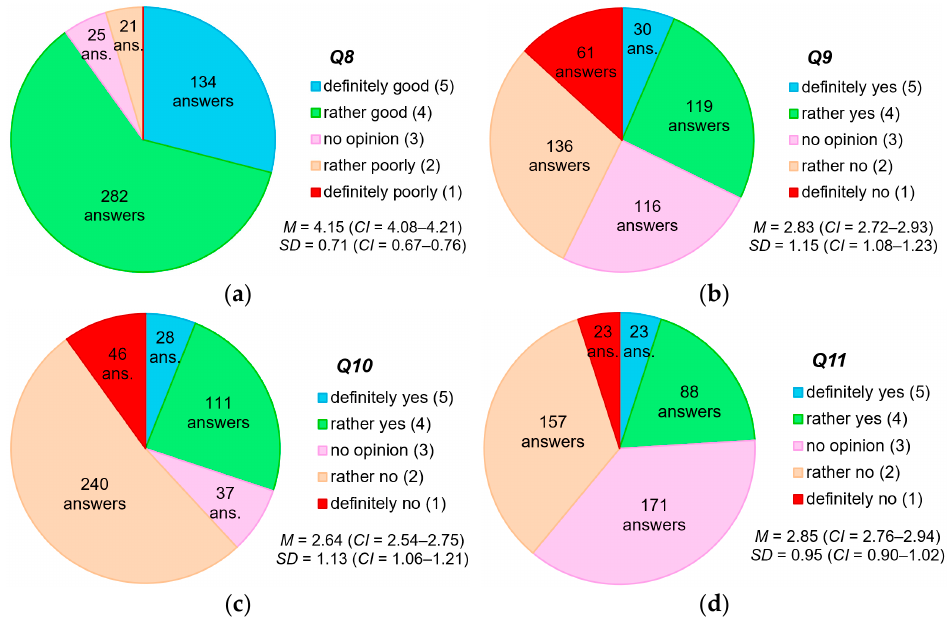
Figure 7. Evaluation of domestic hot water heating systems ( M —average, SD —standard deviation, CI —confidence interval; questions numbers ( Q ) according to the Appendix A): ( a ) question Q 8; ( b ) question Q 9; ( c ) question Q 10; ( d ) question Q 11.